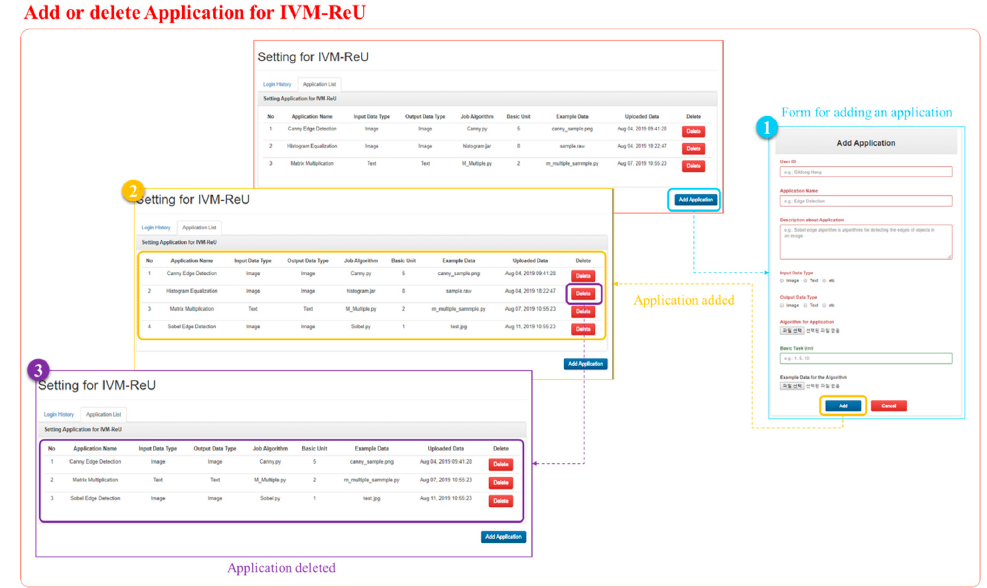
Figure 6. Adding and deleting applications for